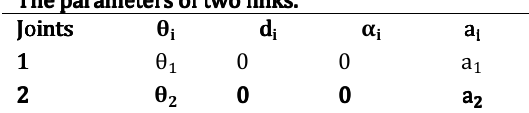
The parameters of two links.